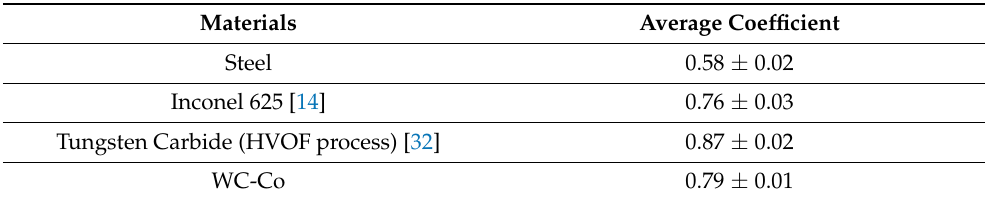
Table 5. Friction coefficients of carbon steel, WC produced by HVOF, Inconel 625 and WC-Co coatings obtained with HP-CS